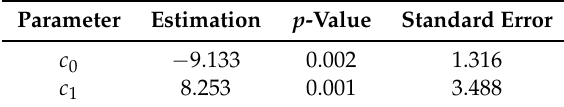
Table 2. Estimation results of Equation (8) for α = 1%.